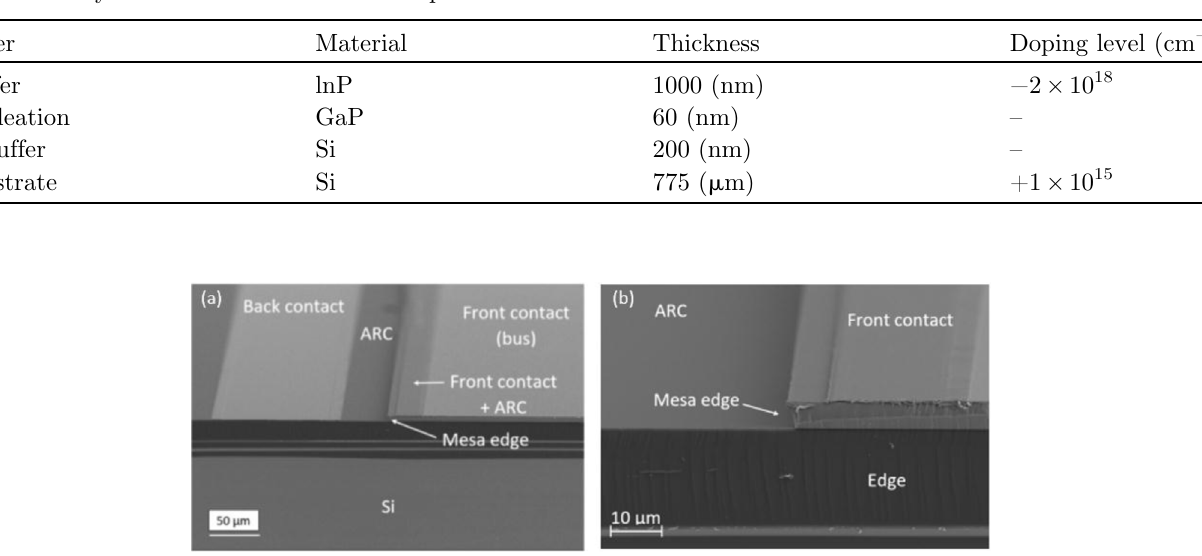
Table 2. Layer structure of the NAsP template.